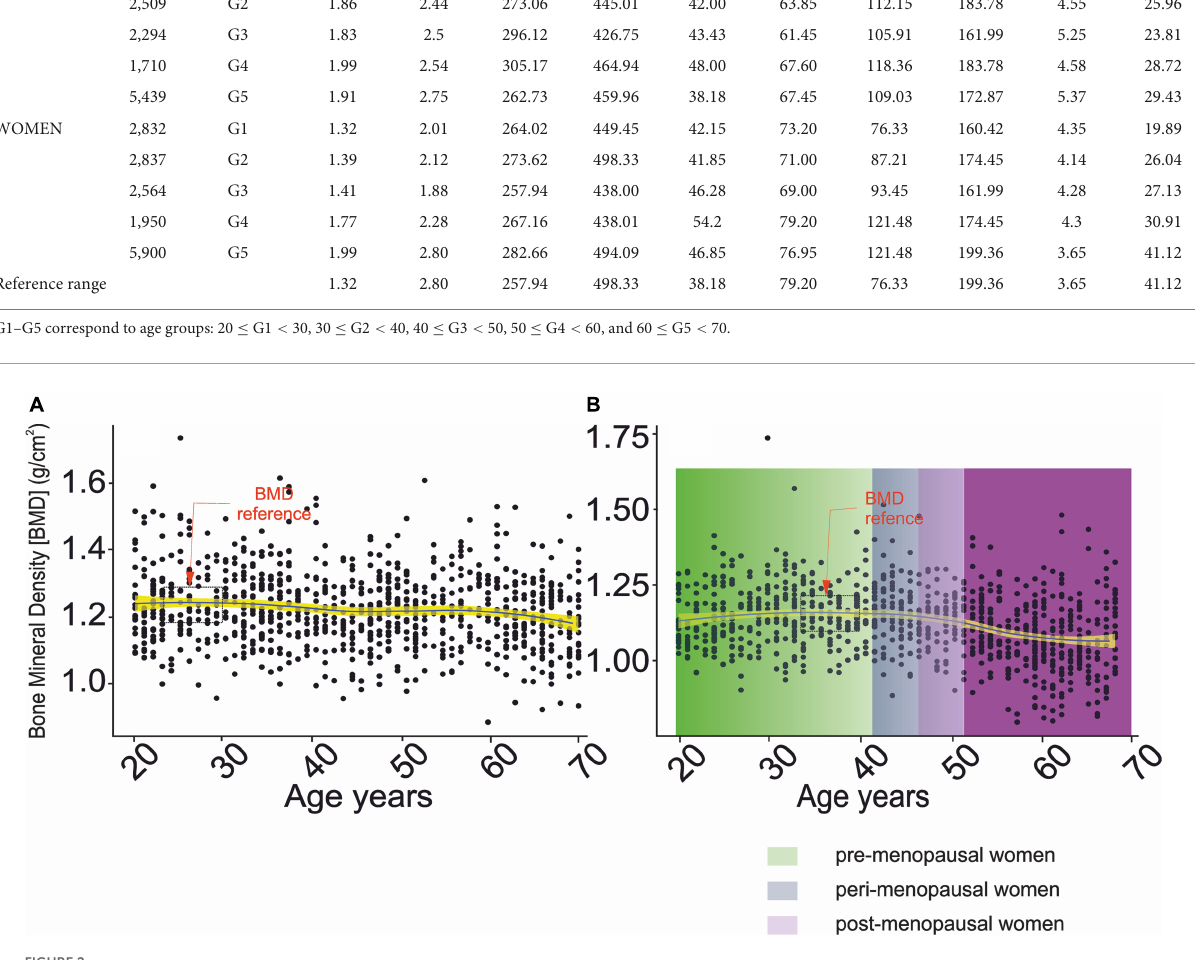
defined as BMD adopting values 1 < µ ≤ 2.5 and µ > 2.5 STD from average healthy subjects